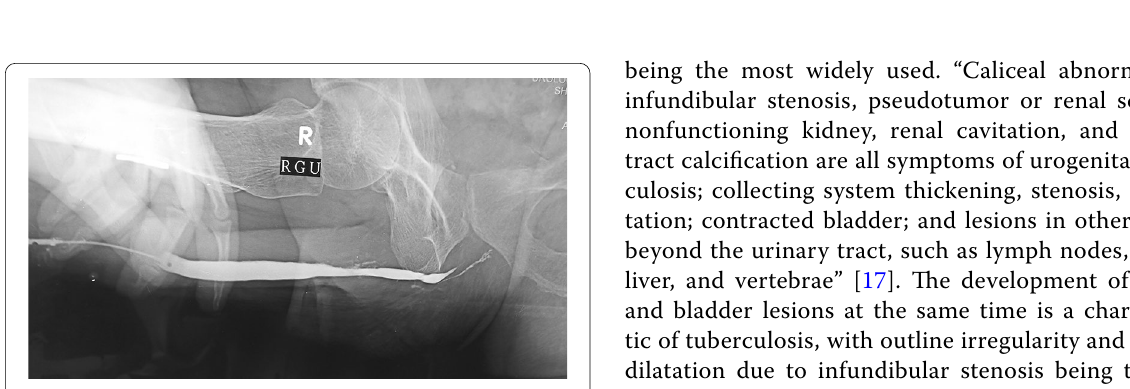
Fig. 5 Retrograde urethrography showing stricture at bulbar